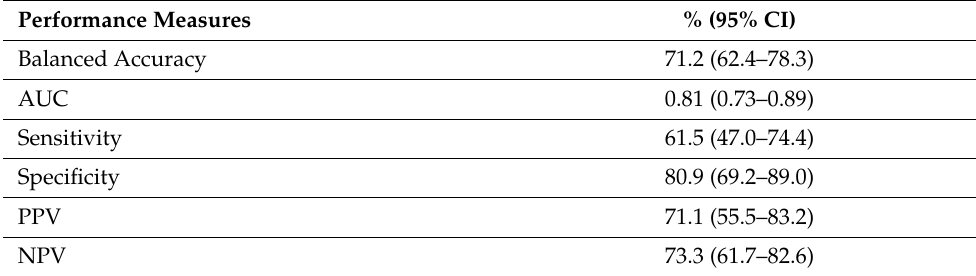
Table 4. Performance measures of naïve Bayes model on the validation set.